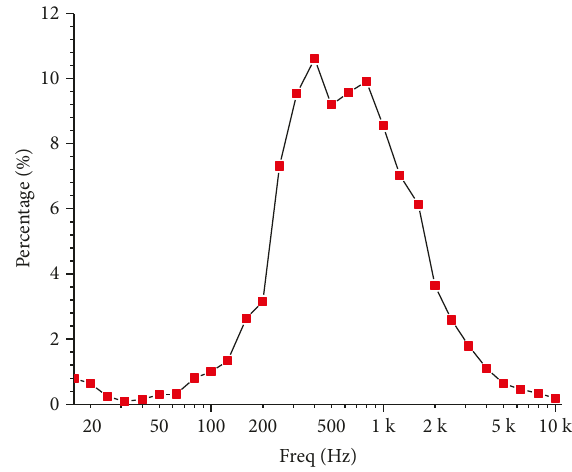
Figure 15: Percentage curve for the sound source energy at each frequency band (free fl ow speed: 83